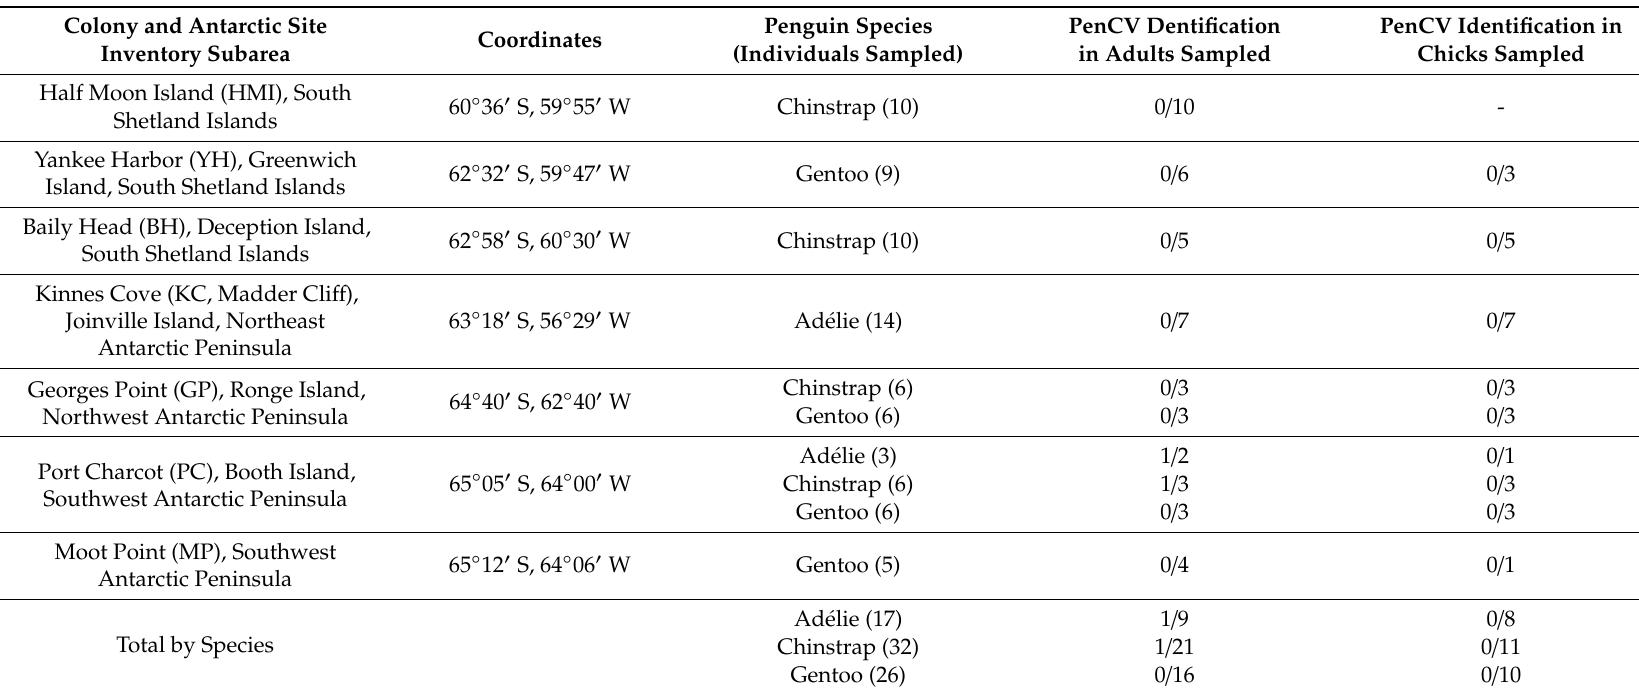
Table 1. Sampling site details and penguin circovirus (PenCV) viral sequence prevalence in adults and chicks. Colony names and subareas follow the Antarctic Site Inventory naming convention